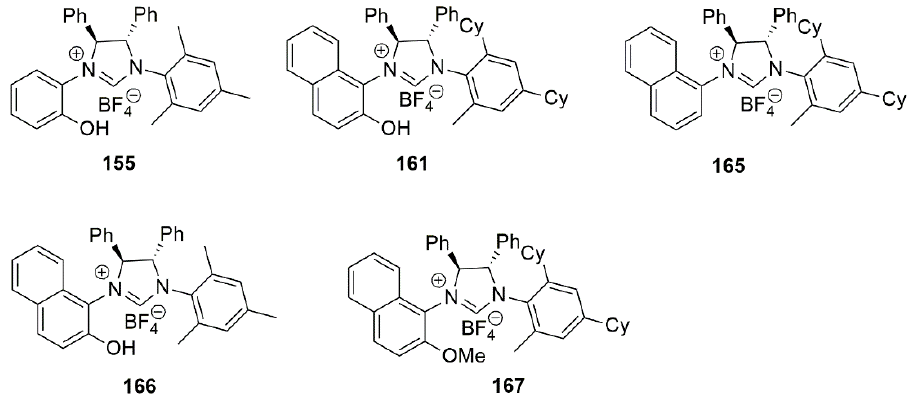
Figure 20. Sawamura’s enantioselective allylic alkylation ligands [174].